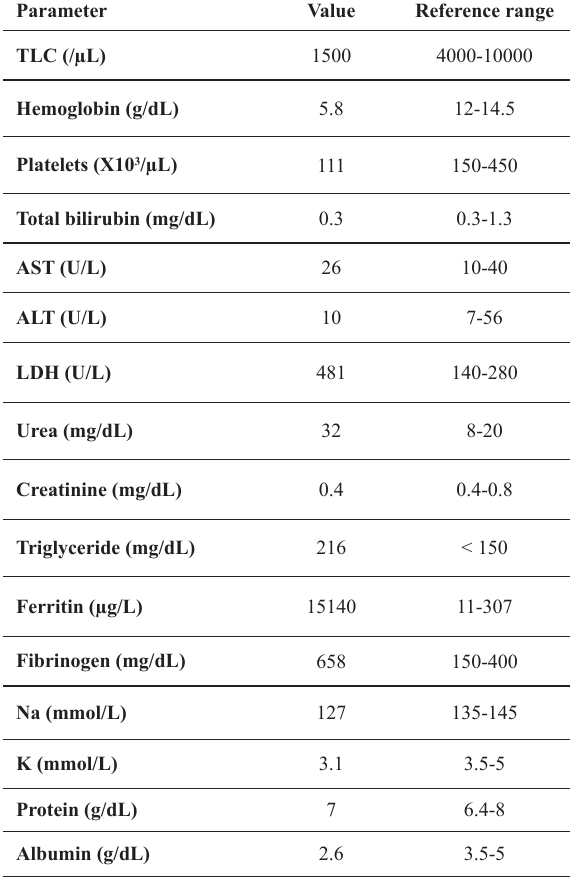
Figure 1: Bone marrow aspirate smear showing macrophages with hemophagocytosis (Giemsa stain, ×1000).